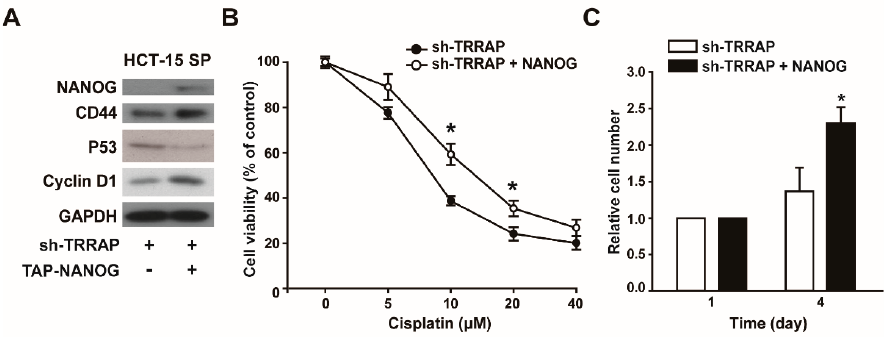
Figure 5. NANOG overexpression rescues the CSC-like characteristics of TRRAP-silenced HCT-15 spheroids. ( A ) Effects of NANOG overexpression on the expression of CD44, P53, and cyclin D1 in TRRAP-silenced HCT-15 spheroids. TRRAP-silenced HCT-15 spheroids were transfected with or without plasmids containing FLAG-NANOG, and the protein levels were determined via Western blotting. ( B ) Effects of NANOG overexpression on drug resistance in TRRAP-silenced HCT-15 spheroids. TRRAP-silenced HCT-15 spheroids were transfected with control or NANOG expression